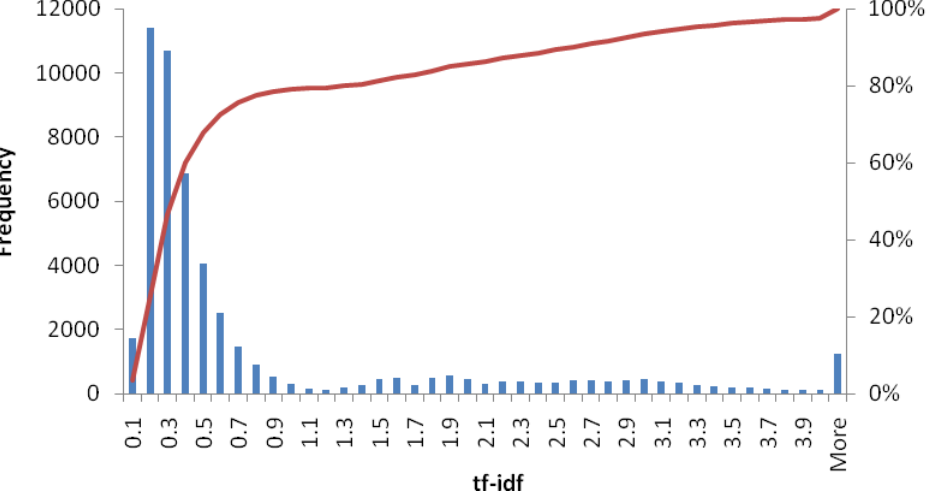
Figure 4: Histogram (blue) and cumulative frequency distribution (red) of tf-idf scores from 52430 protein/stress entities found in the Arabidopsis corpus by named entity recognition. For details see